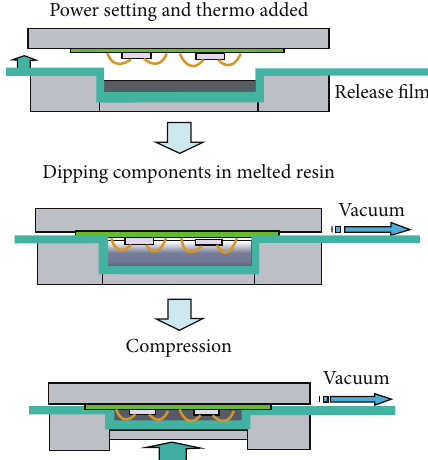
Figure 1: Compression molding process for LED molding